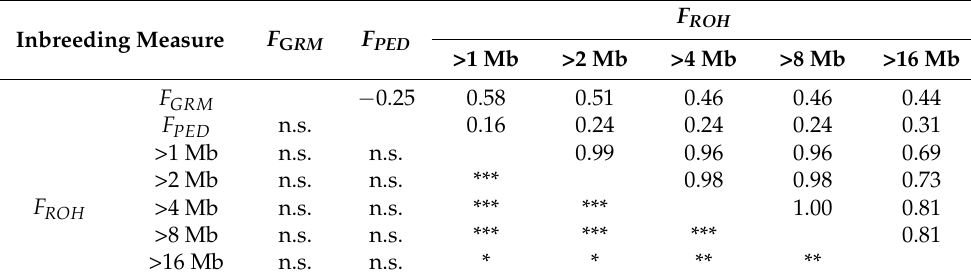
Table 4. Pearson’s correlations (above diagonal) among genomic ( (cid:1832) (cid:3008)(cid:3019)(cid:3014) ), pedigree ( (cid:1832) (cid:3017)(cid:3006)(cid:3005) ) and Runs of Homozygosity ( (cid:1832) (cid:3019)(cid:3016)(cid:3009) ) based inbreeding coefficients, significance values 1 are reported below the diagonal.